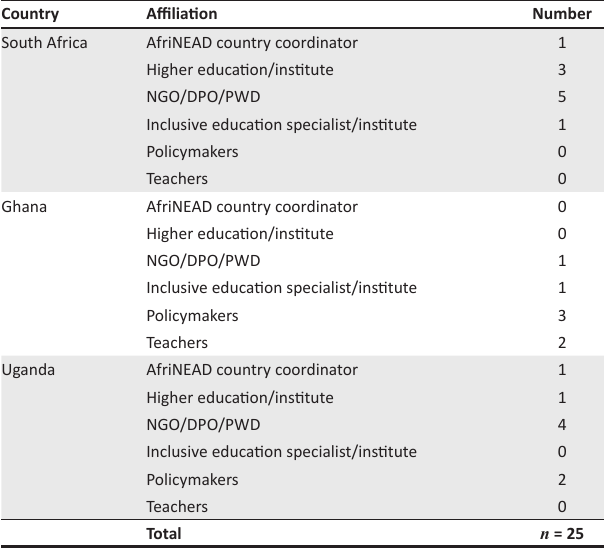
TABLE 1: The study sample according to the country.